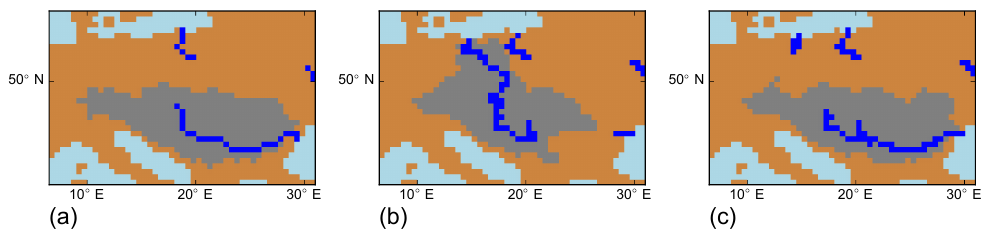
Figure 2. Comparison of the Danube catchment showing the catchment (grey area) and rivers with a total cumulative inflow greater than or equal to 75 cells (blue cells) derived from (a) manually corrected 0 . 5 ◦ HD model river directions as a reference, (b) automatically generated river directions for a 10min grid and (c) automatically generated river directions for a 10min grid once height corrections have been applied to a few selected cells in the